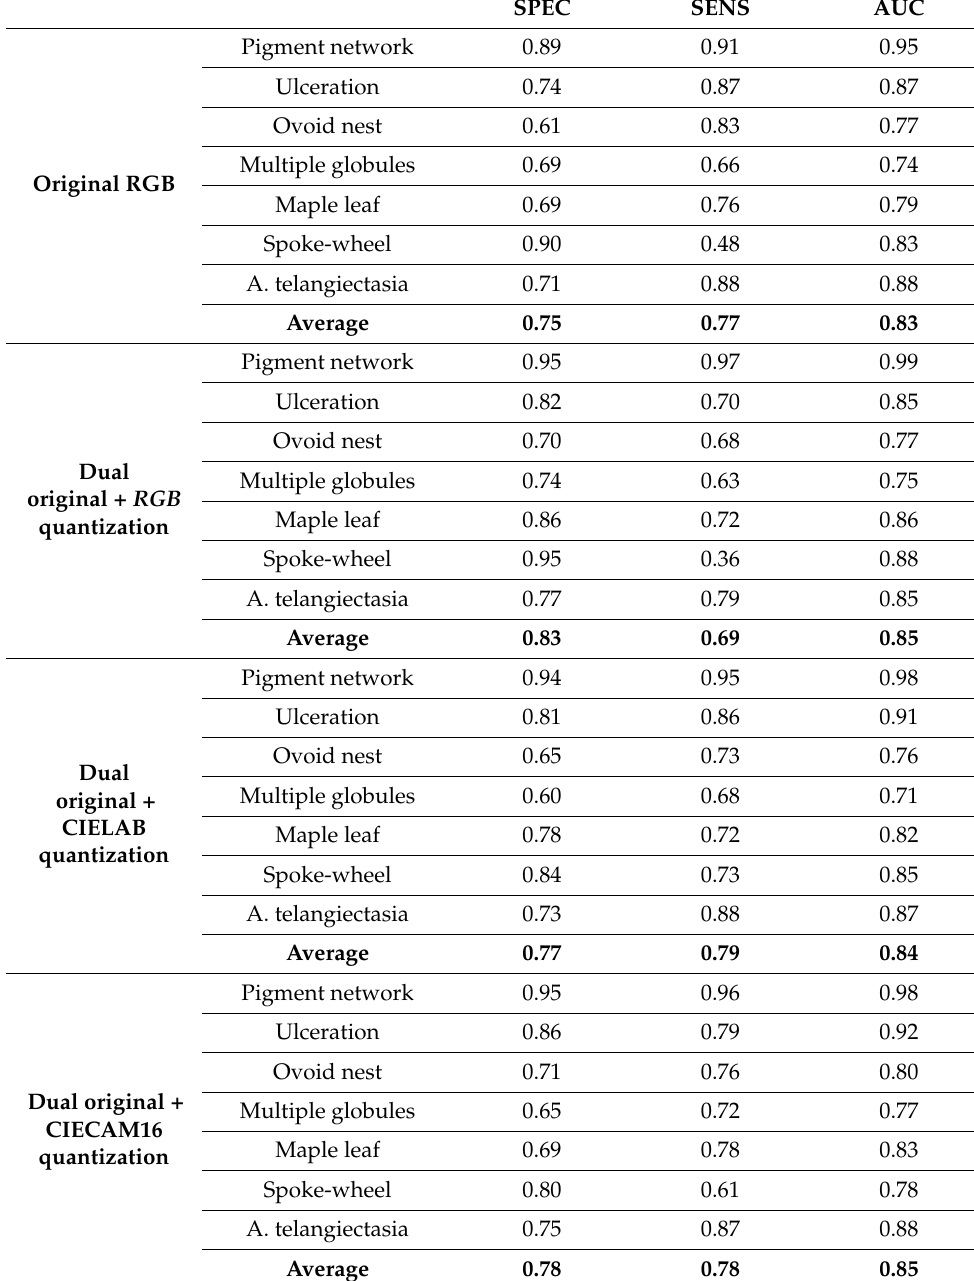
Table 2. Evaluation results for Test 1 and Test 2 classifications. SPEC: specificity; SENS: sensitivity; AUC: area under the